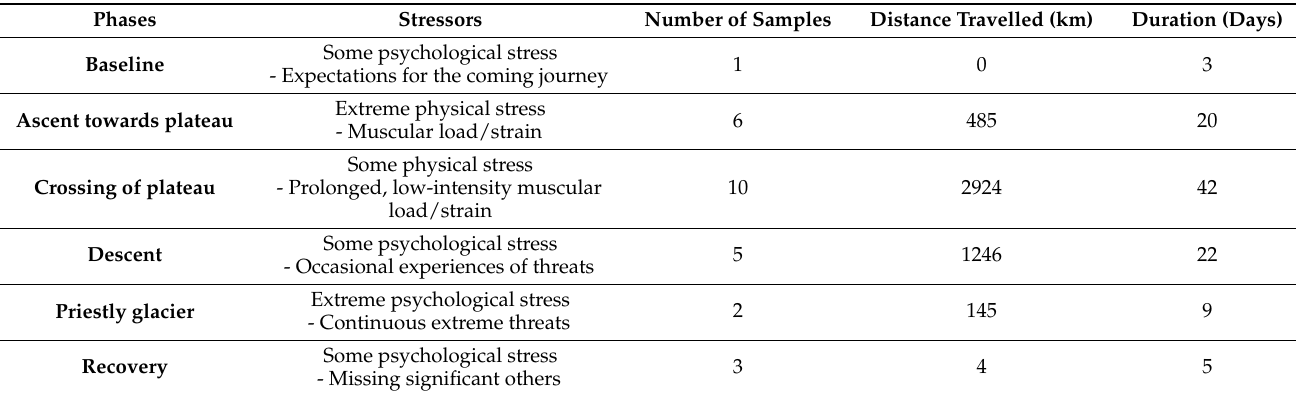
Table 3. Phases of the expedition based on intensity and type of stressors as well as number of data recordings, distance travelled and duration, separated for each phase. Based on